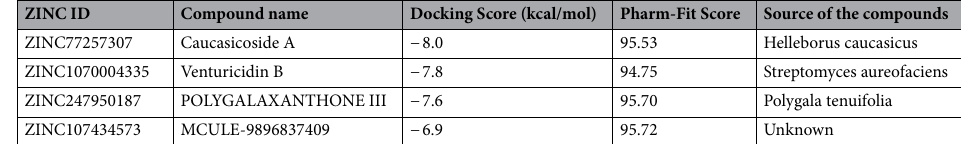
ZINC ID Compound